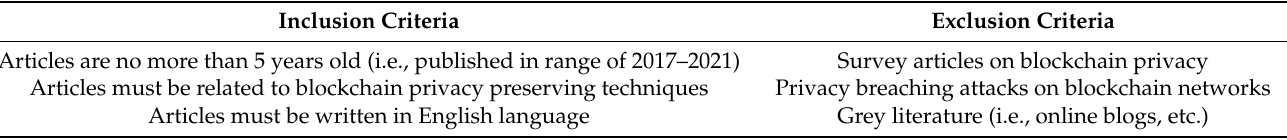
Table 3. Comparative analysis of privacy preserving